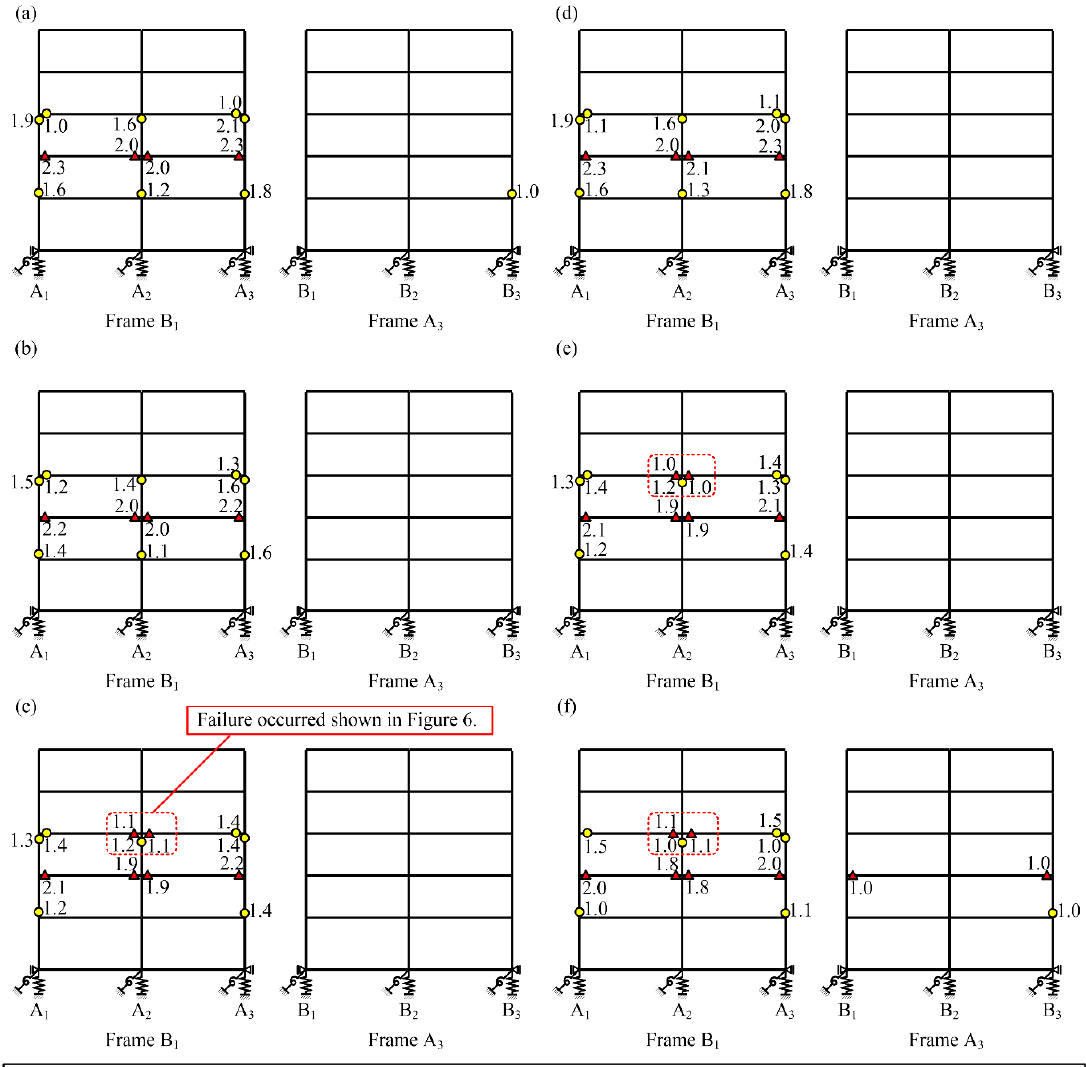
Figure 29. Distribution of the yielding hinges at frame B 1 and A 3 in each model ( λ = C I, bi ): ( a ) Model-RuW1-100, ( b ) Model-RuW2-100, ( c ) Model-RuW4-100, ( d ) Model-RuW1-050, ( e ) Model-RuW2-050, and ( f ) Model-RuW4-050.